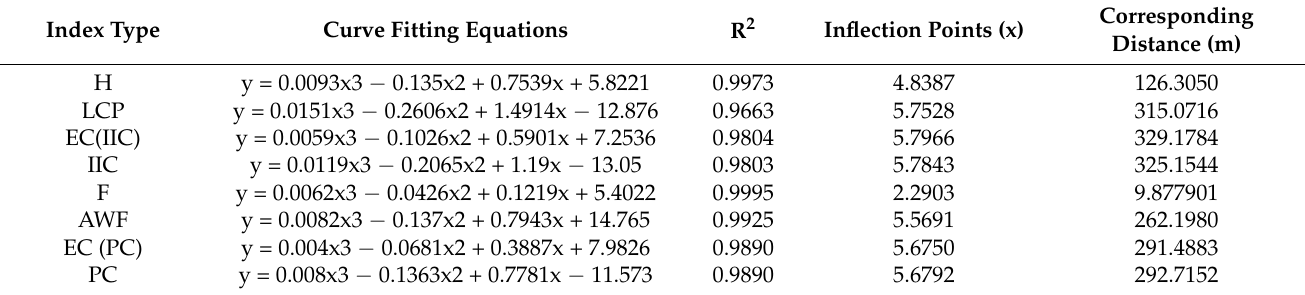
Table 2. Curve fitting equations and inflection points.